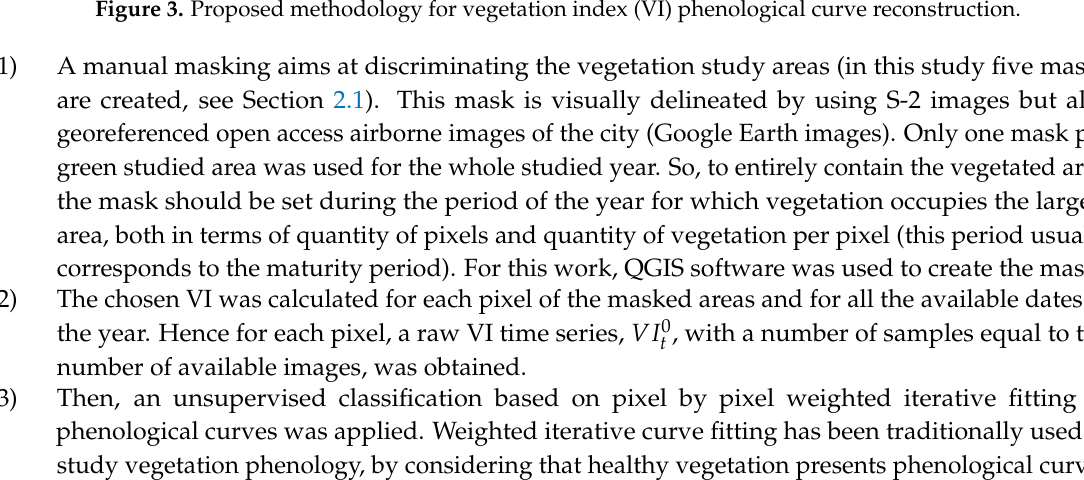
Figure 3. Proposed methodology for vegetation index (VI) phenological curve